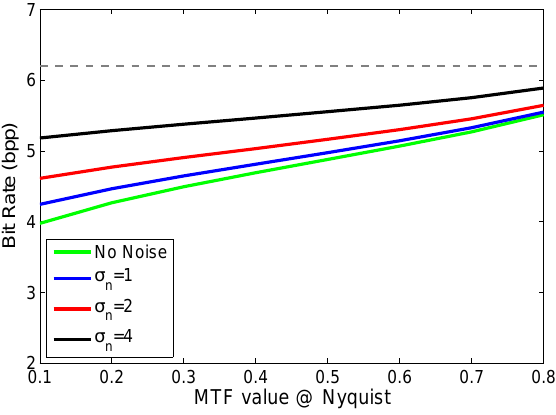
Figure 9. BR versus K min by varying σ n for the Yellowstone scene 0 in BSQ